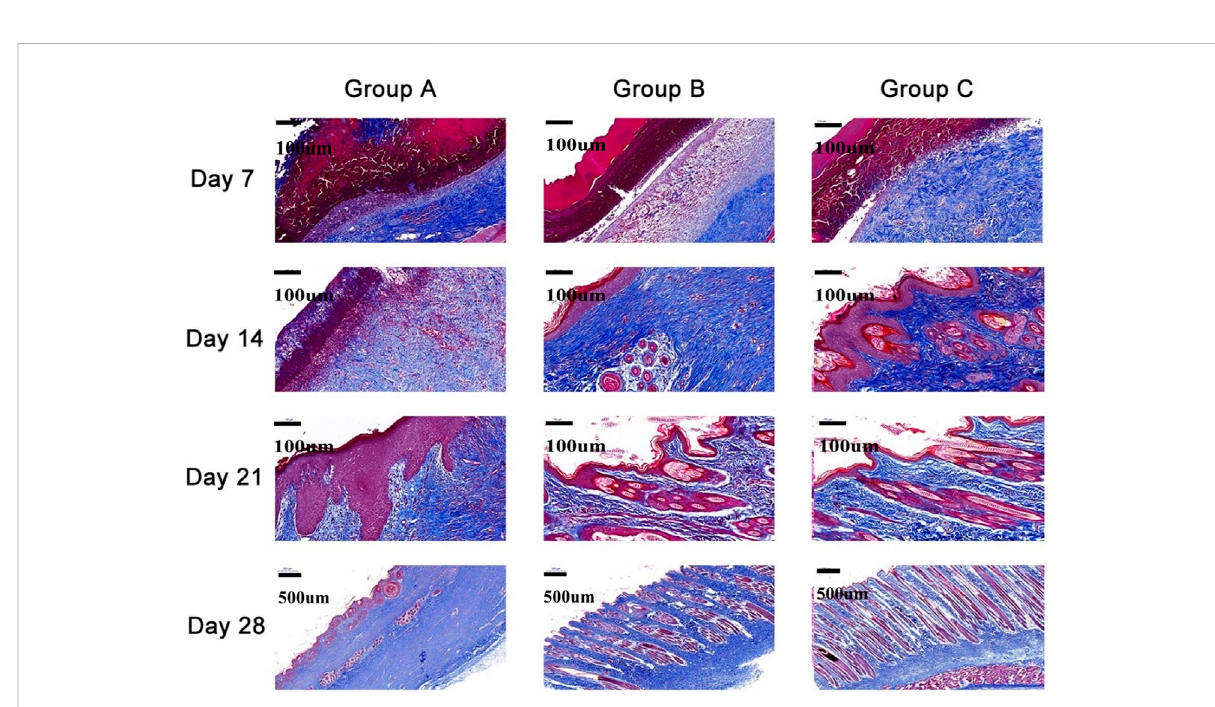
FIGURE 7 Representative images of Masson histologic wound sections of group (A – C)